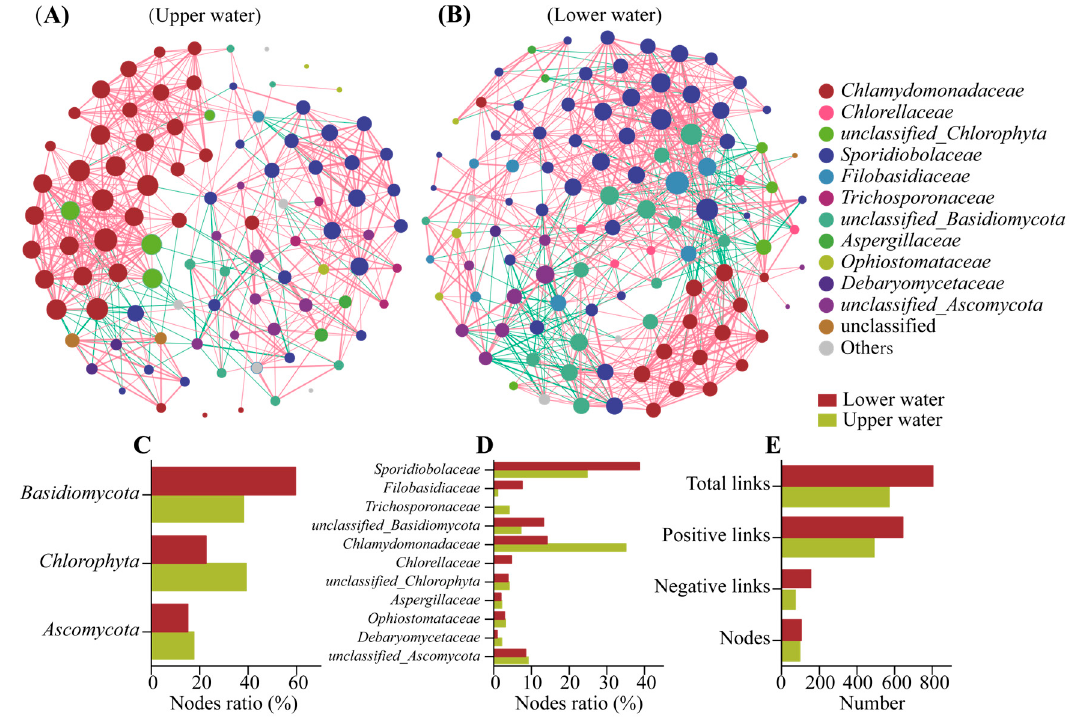
Figure 3. Co-occurrence network of microbial interactions based on top ASVs in the upper ( A ) and lower water ( B ). A connection stands for the significant Spearman correlation with 0.7 < |r| <1 ( p < 0.05). The size of a node is proportional to the degree. The node color represents the assignment at family level. Number of keystones ASVs within two networks were counted at phylum ( C ) and family level ( D ). Network properties, including the number of links and nodes ( E ) were also presented.